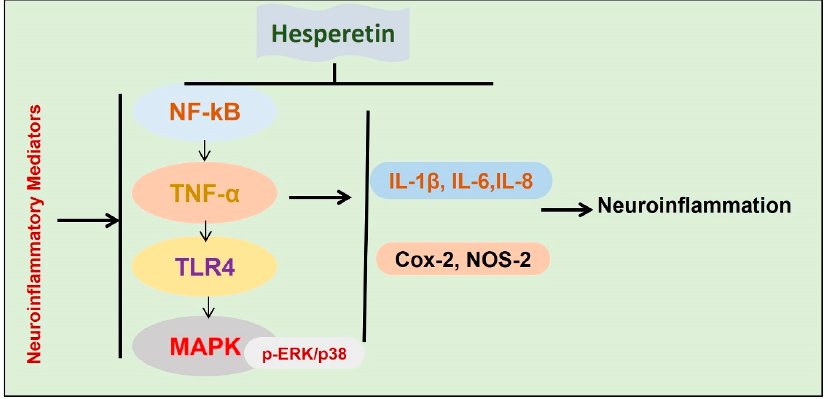
Figure 6. Effects of hesperetin against neuroinflammatory mediators. A diagram showing the effects Figure 6. E ff ects of hesperetin against neuroinflammatory mediators. A diagram showing the e ff ects of of hesperetin against the inflammatory mediators in different models of neurodegenerative diseases. hesperetin against the inflammatory mediators in di ff erent models of neurodegenerative